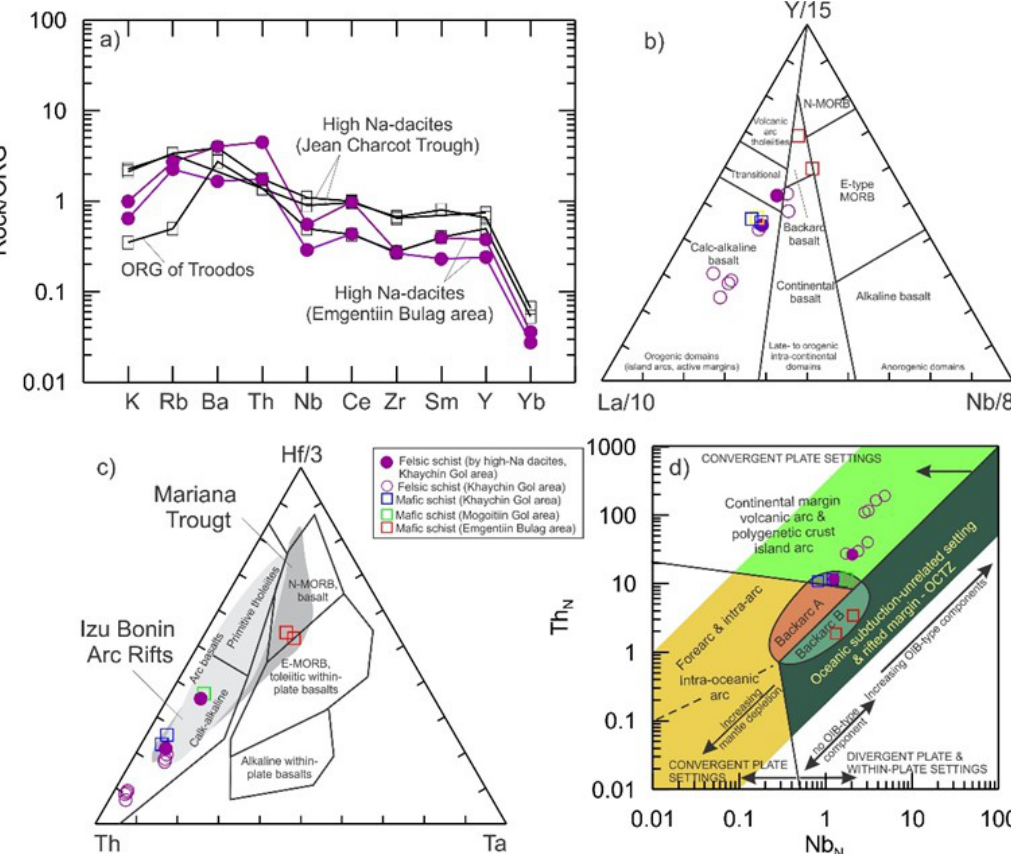
Fig. 12. a) Comparison of incompatible element patterns of the High-Na dacites from